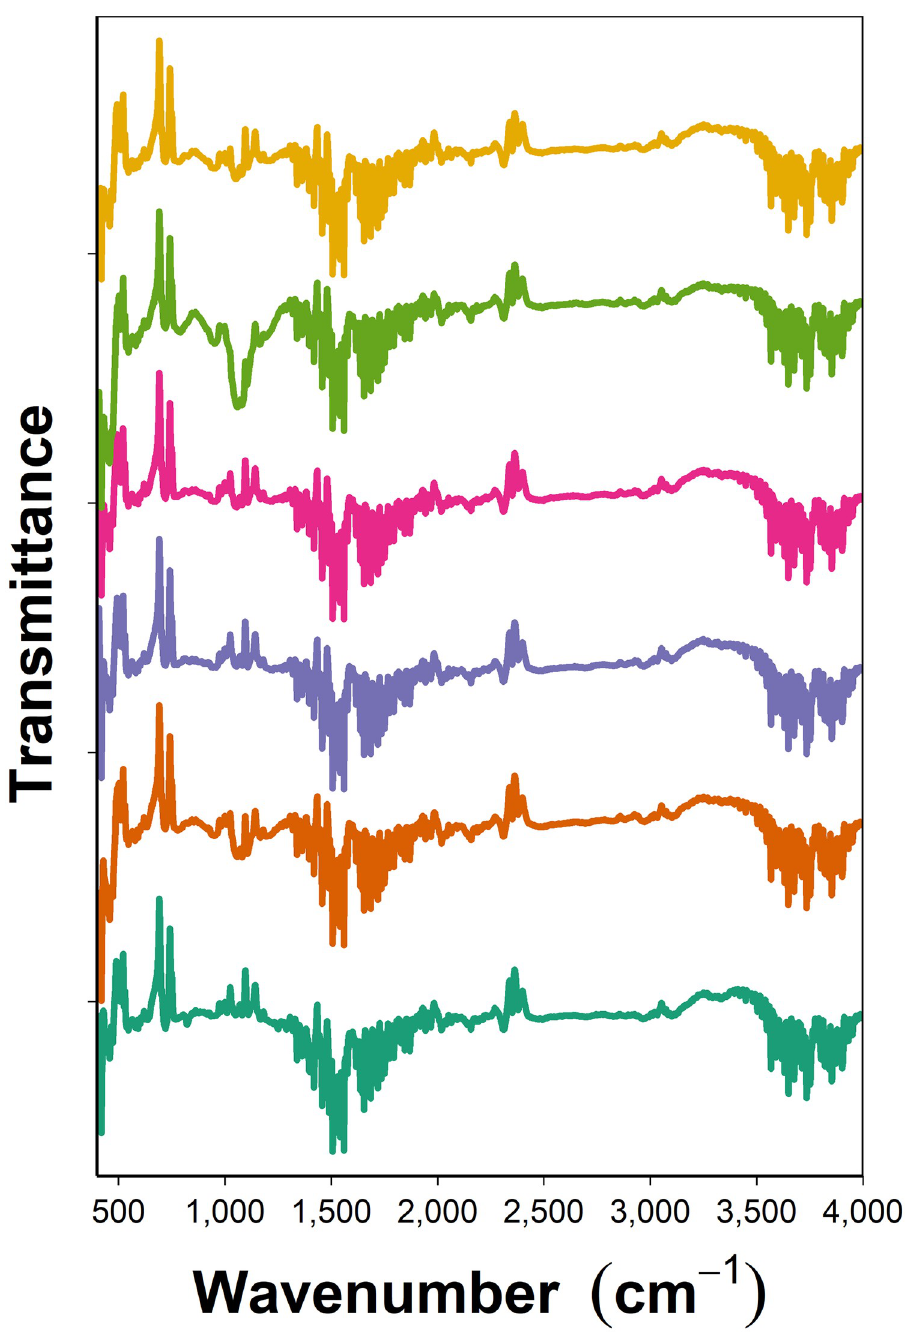
Fig 2. FTIR of chlorhexidine coated nanocarriers. Example of FTIR spectra of pure chlorhexidine ( — ) and of the coated nanocarriers after deposition of chlorhexidine during construction of QL1 ( — ), QL3 ( — ), QL5 ( — ), QL7 ( — ) and QL10 ( —